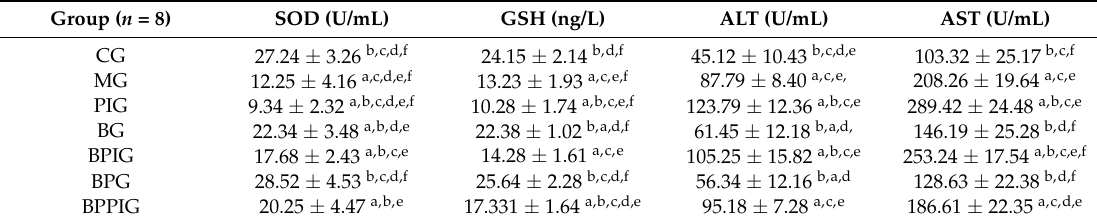
Table 6. Biochemical parameters of enzyme activities for